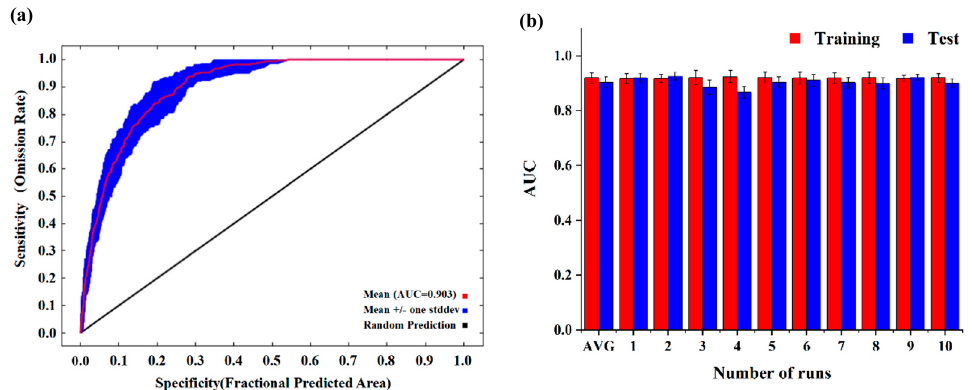
Figure 3. Receiver operator characteristic (ROC) curve and model testing and training AUC values